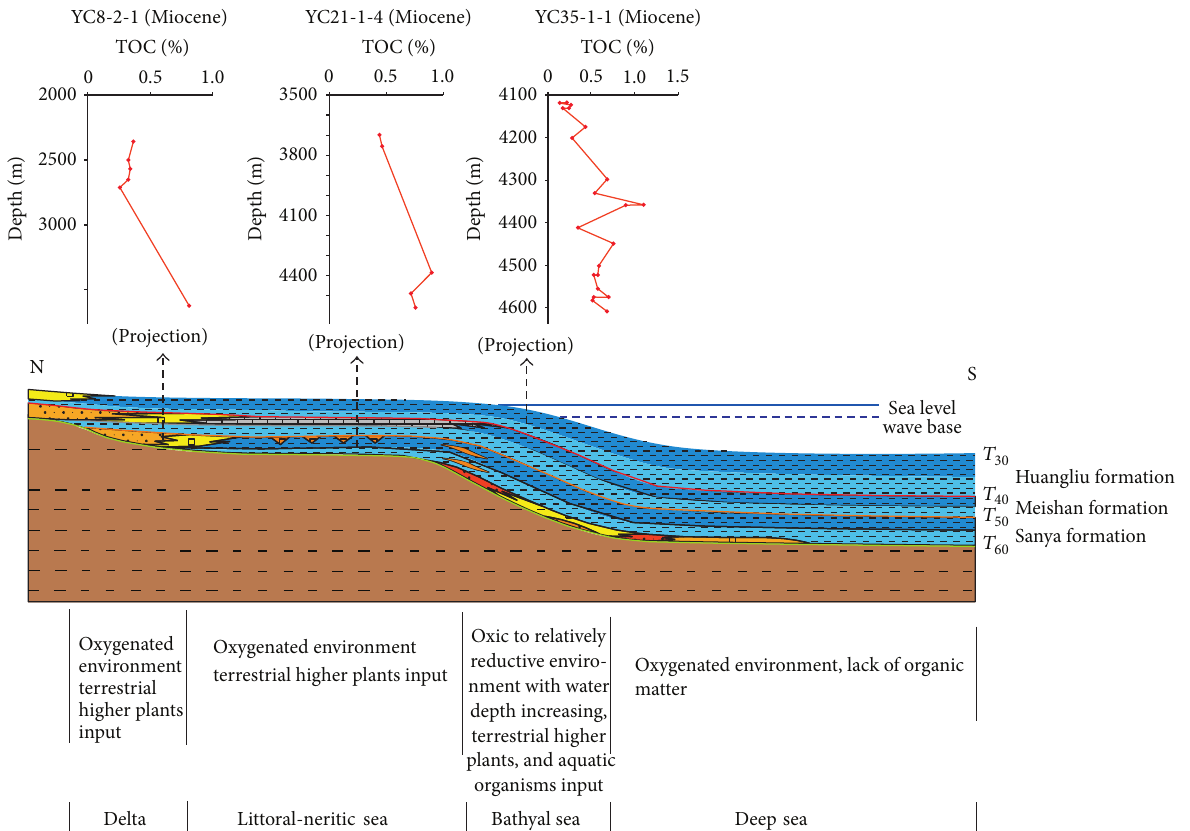
Figure 10: The depositional patterns of Miocene marine source rocks in the Qiongdongnan